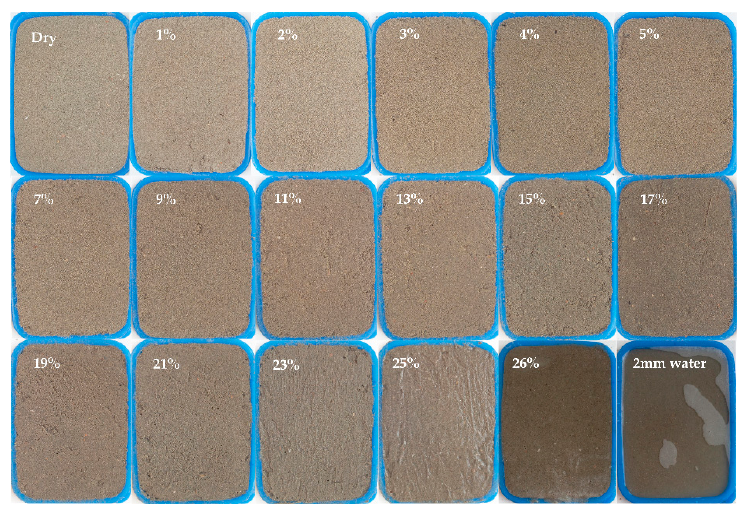
Figure 3. The close-up images of the sand samples with different moisture contents. The size of each plastic container has a 5 mm depth × a 10 cm width × a 20 cm length.